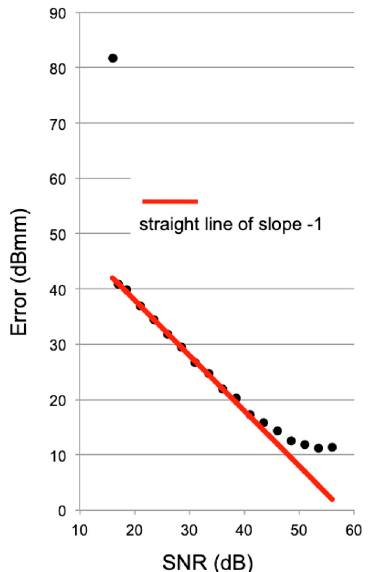
Figure 9. Range of error evaluated for different signal-to-noise ratios (SNR). The red line is an interpolating straight line of slope − 1.